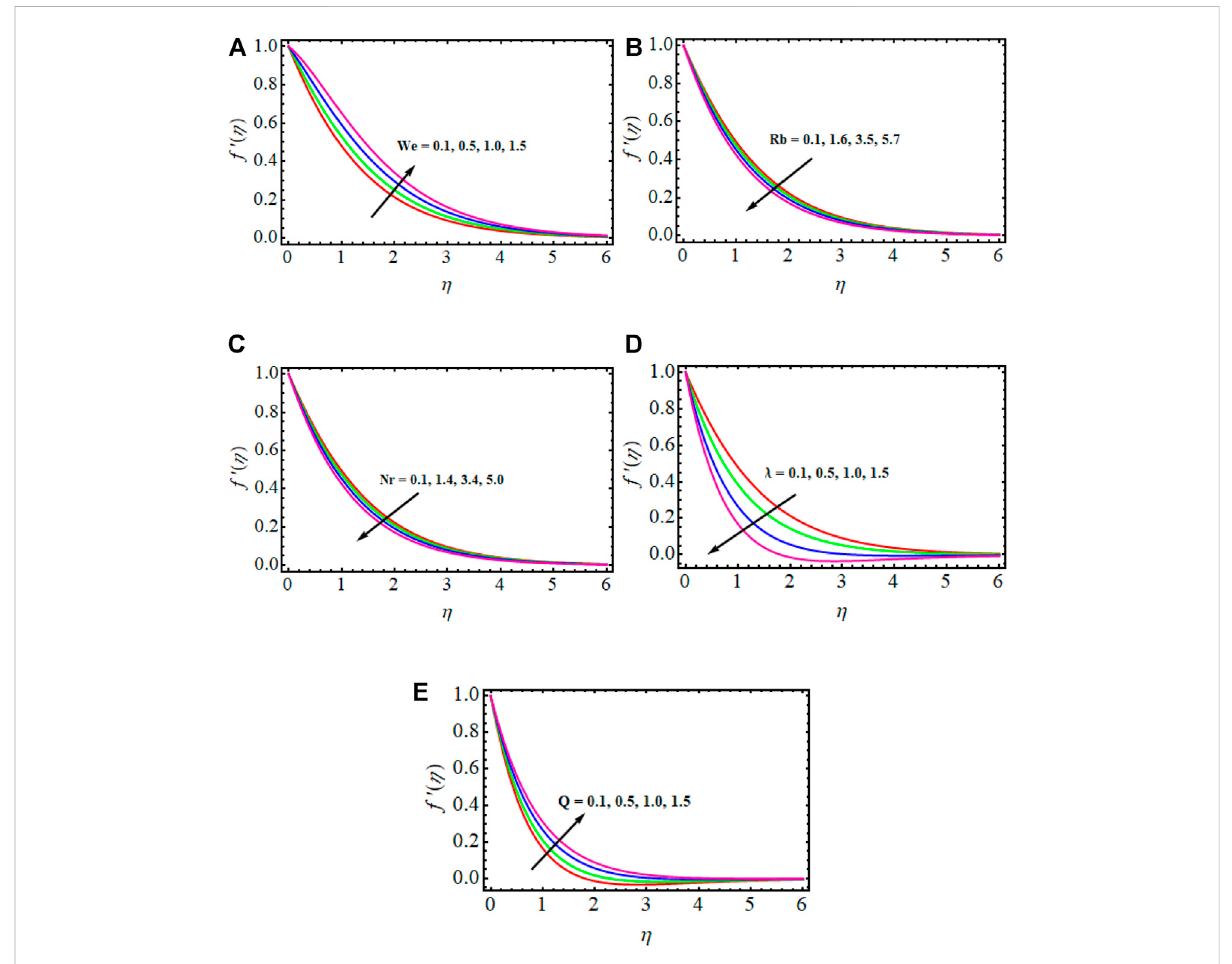
FIGURE 3 Alteration of We , Rb , Nr , λ , and Q with velocity pro fi le f ′ ( η )